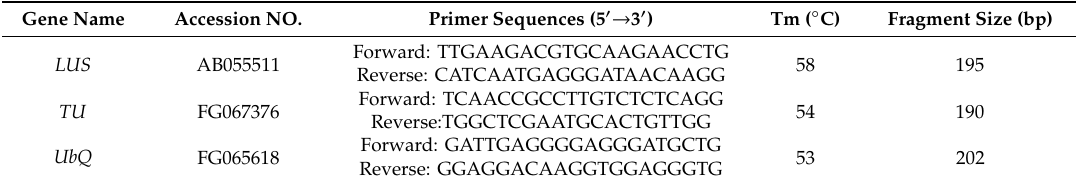
Table 1. Sequences of primer pairs for quantitative real-time RT-PCR (qRT-PCR)